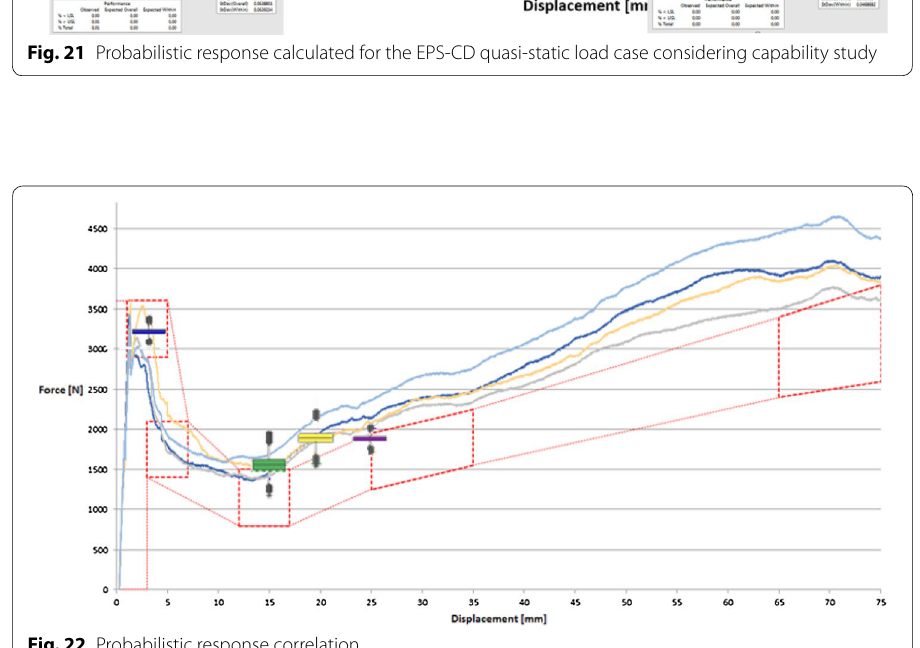
Fig. 22 Probabilistic response